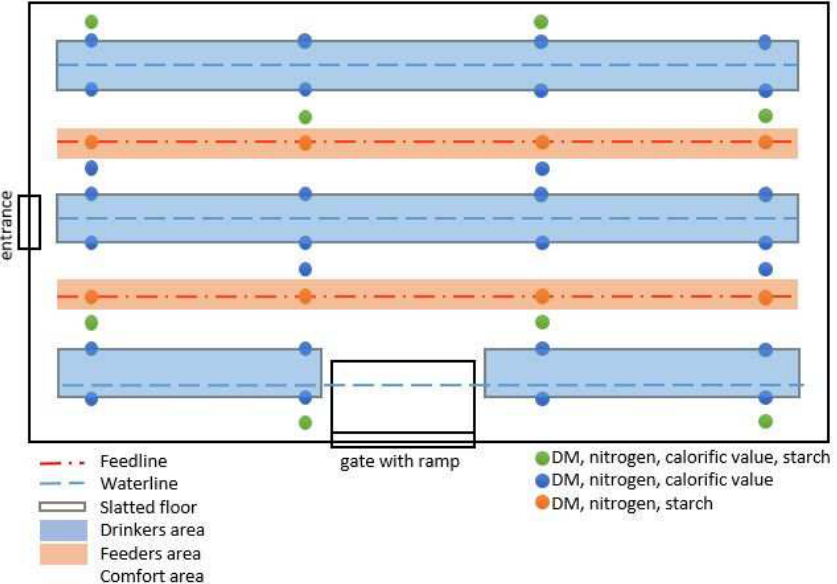
Figure 4. Shown is the sampling plan of the experimental barn. The blue (dashed) and red (dashed- dotted) lines are water and feeding lines. Therefore, the blue and red areas are the drinker and feeder areas. The white space is the comfort area. The green sample points were analyzed for DM, nitrogen, calorific value and starch, whereas the blue sample points were analyzed for DM, nitrogen and calorific values. The red sample points were analyzed for DM, nitrogen and starch.